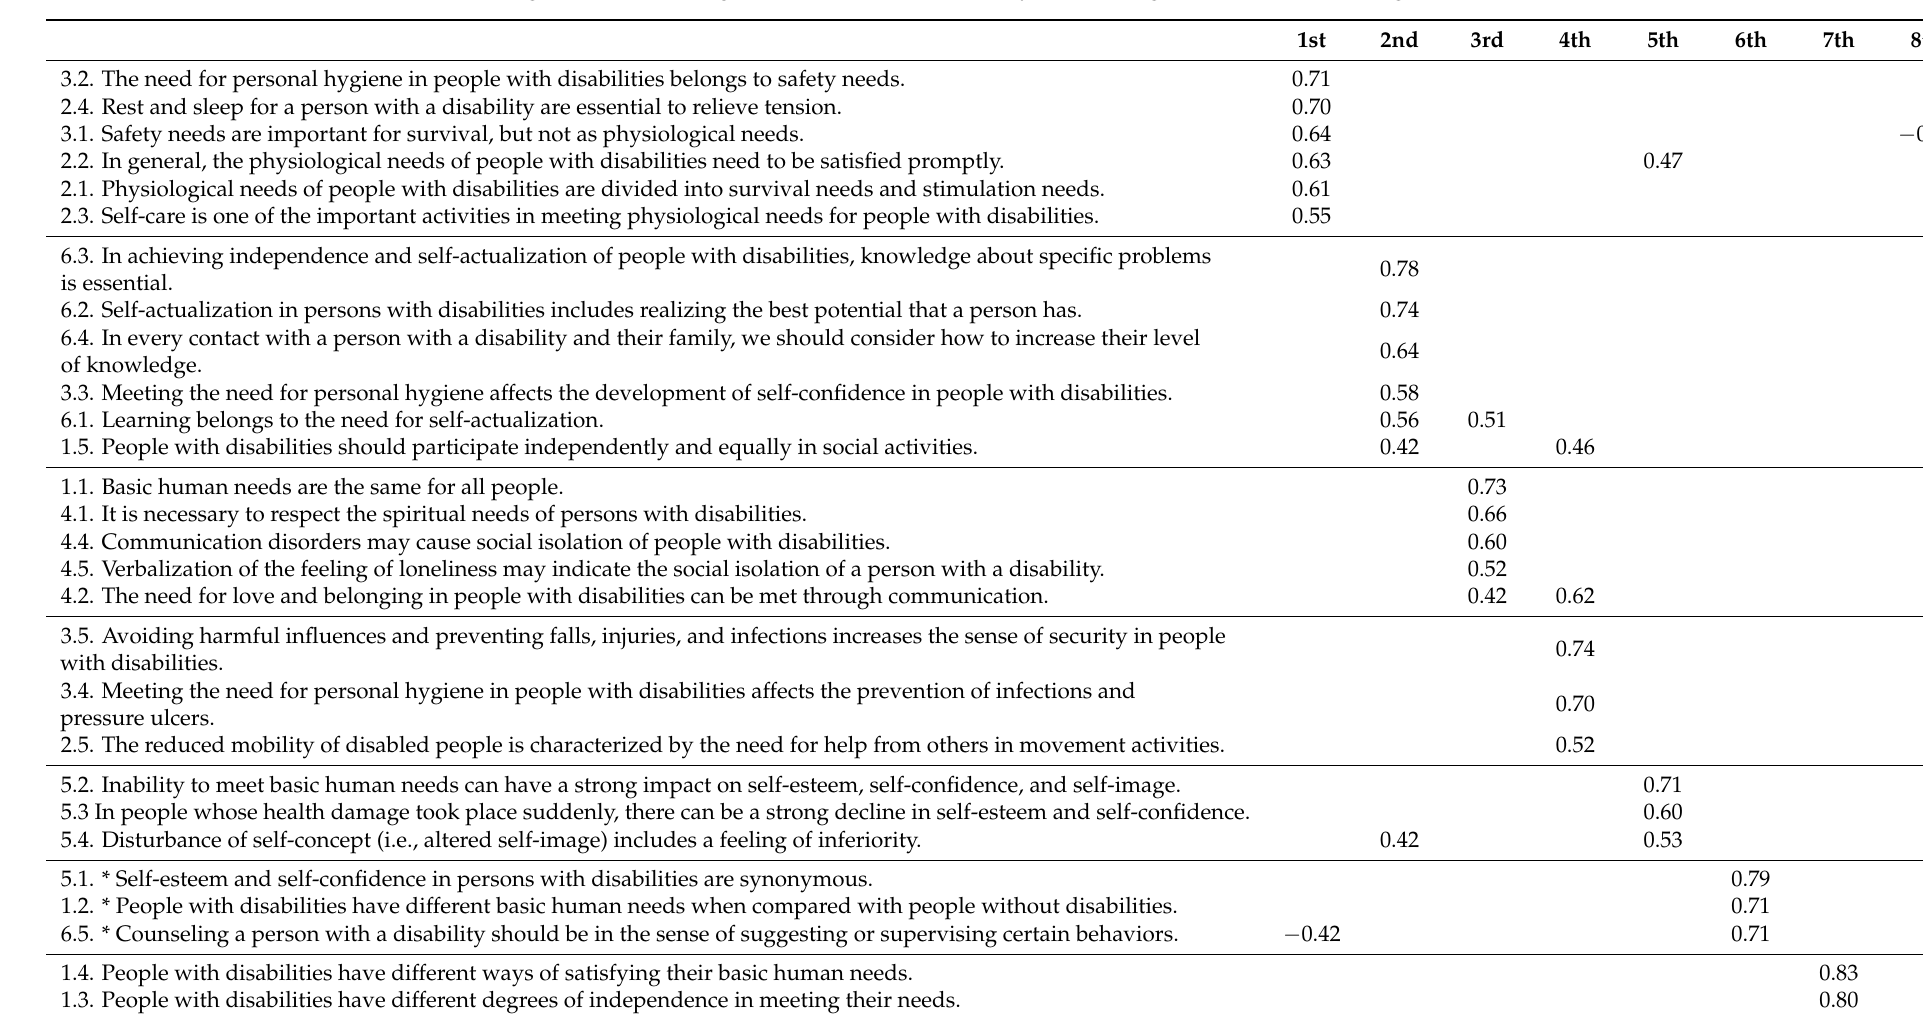
Table 2. Loadings of the items of eight factors of the factorial analysis according to the nurses’